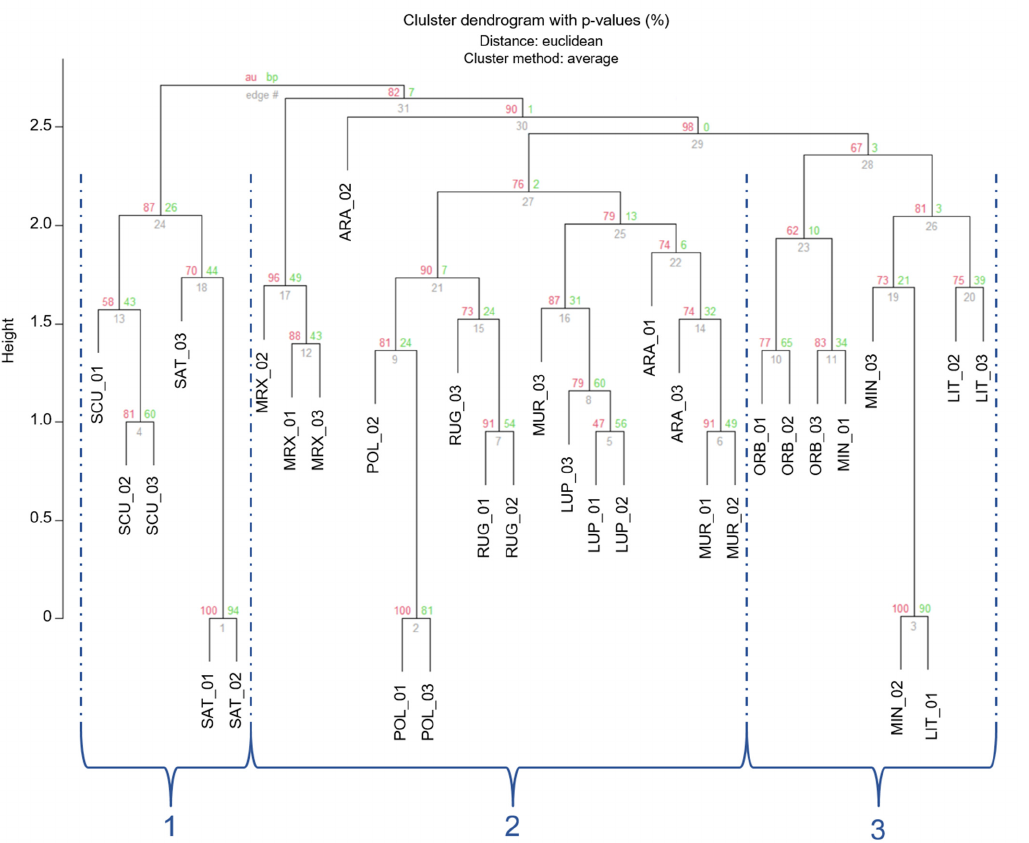
Figure 3. Cluster dendrogram of the 33 Medicago individuals based on the Euclidean distances. Val-